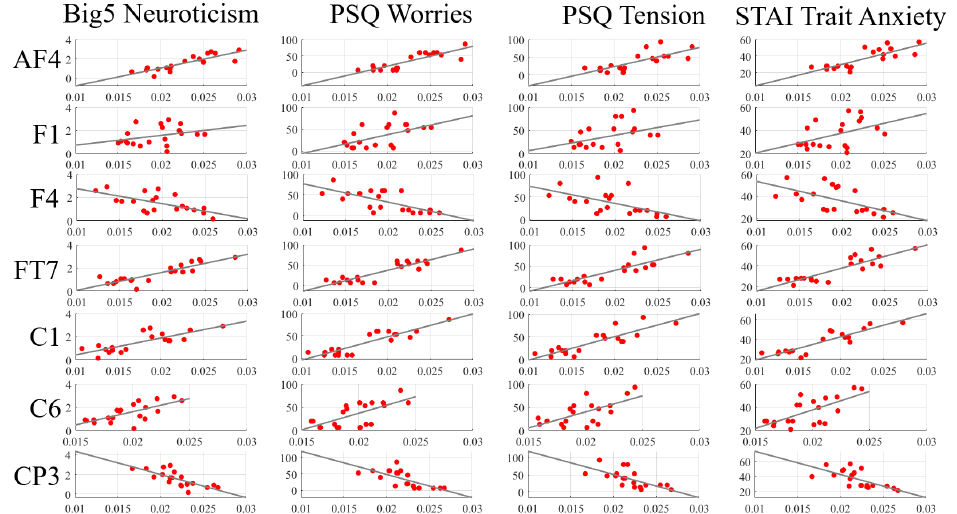
Figure A14. Eyes-Open (EO) setting. Spearman correlation between participants’ responses to questionnaires and their cumulative TEs. These TEs correspond to EEG channels whose cumulative TEs were significantly different between HIGH versus LOW stress-susceptible participants. The figure shows the first half of these channels: AF4, F1, F4, FT7, C1, C6, CP3. The second half of these channels are shown in Figure A15. The channels are marked along the vertical axis of each subplot in the figure. The questionnaires are marked on the top of each subplot and along their horizontal